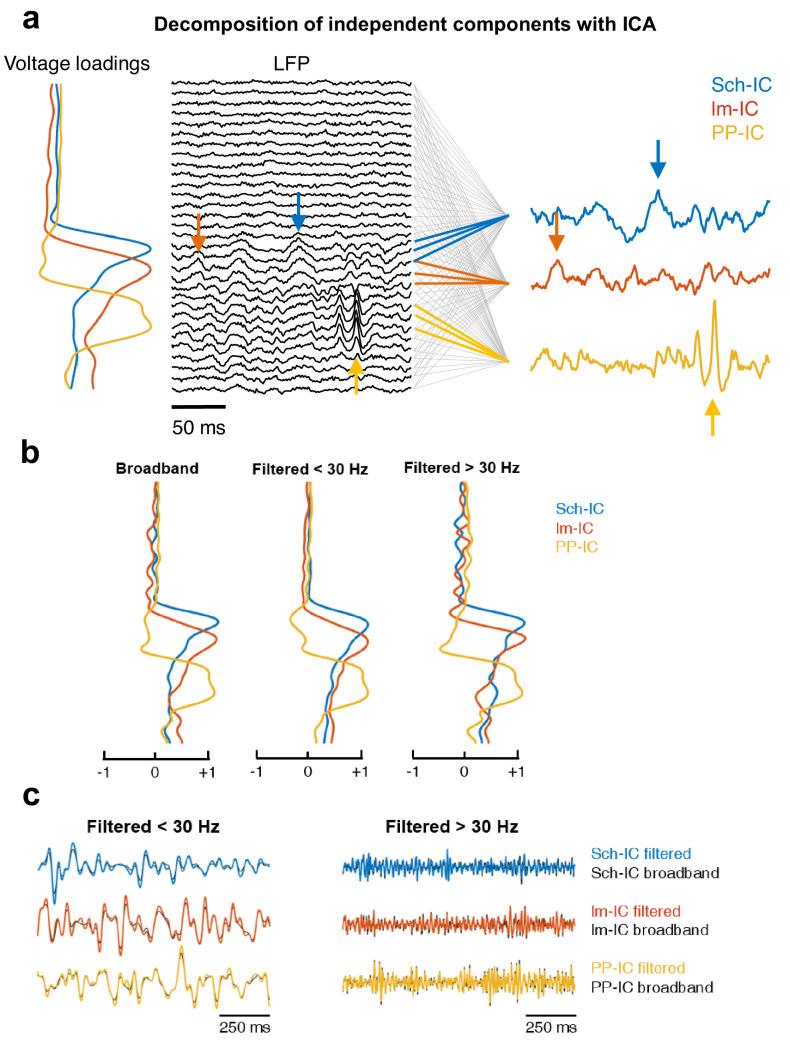
Example of application of ICA.(a) Diagram of the decomposition of independent components with ICA. The algorithm computes a mixing matrix or voltage loadings which represents the contribution of the sources (independent components) to each LFP channel. The lines between the LFP and the three IC-LFPs indicate which LFP channels have information of each source, based on the voltage loadings. Those channels with a minor contribution are linked with gray lines, while in color there are the channels with the main contribution of each IC-LFP. Note that one LFP channel may contain information of different sources at the same time. We can identify how specific events in the IC-LFPs are spread along their associated LFP channels (arrows). (b) Voltage loadings obtained from an ICA applied to the raw (broadband) LFP recording (left), to the same LFP but low-pass filtered at 30 Hz (center) or high-pass filtered at 30 Hz (right). In all cases, the three main components share a common spatial pattern, with maximums at their afferent hippocampal pathway. (c) Examples of time series comparing the IC-LFP extracted by computing the ICA algorithm and then filtering the signal (black traces), versus those obtained by filtering first the LFPs and then applying ICA (color-coded traces). There are no significant differences neither in the phase of the theta rhythm (center, low-pass filtered at 30 Hz) nor in the amplitude of gamma oscillations (right, high-pass filtered at 30 Hz).